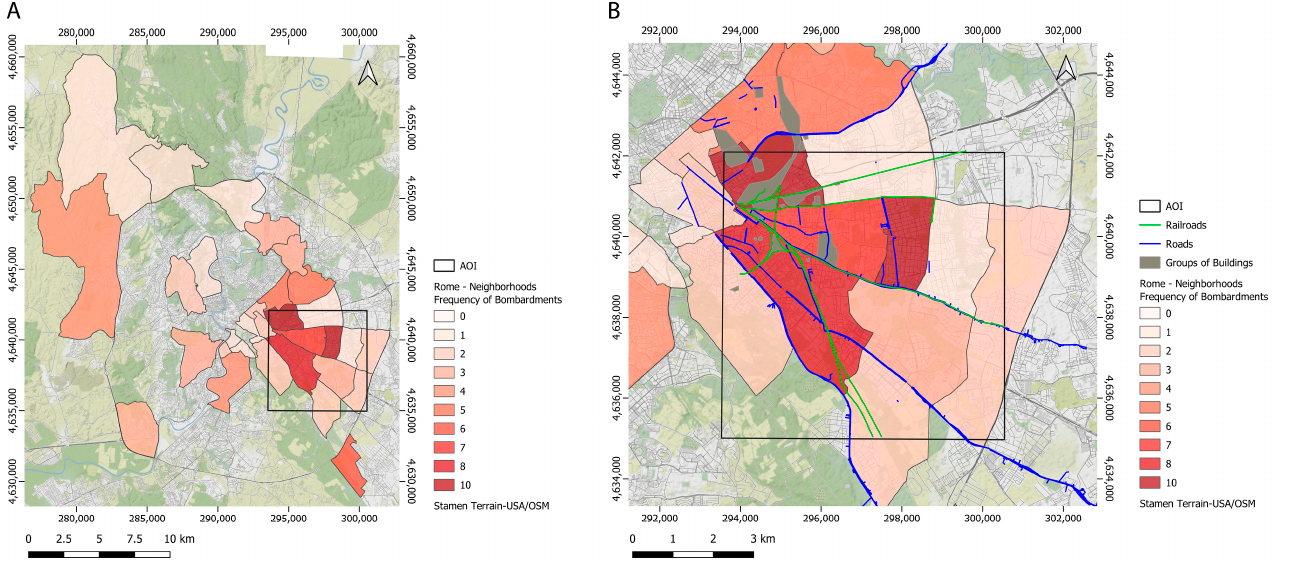
Figure 5. Display of the shapefile catalogs of the air-raid events that occurred during WWII through the use of vectors. ( A ) The Neighborhoods vector is displayed with a color-ramp on the Frequency attribute. The base polygon shapefile of the Neighborhoods layer comes from the vector retrieved from [72], whose attribute table was used to archive the historical information. ( B ) Detailed view of the AOI and direct surroundings with specific vectors that described the bombed roads, railroads, groups of buildings and neighborhoods. The baseline vector of roads and railroads comes from the CTR of Rome [73], shared under a cc-by license, whose attribute table was also used to archive the historical information.